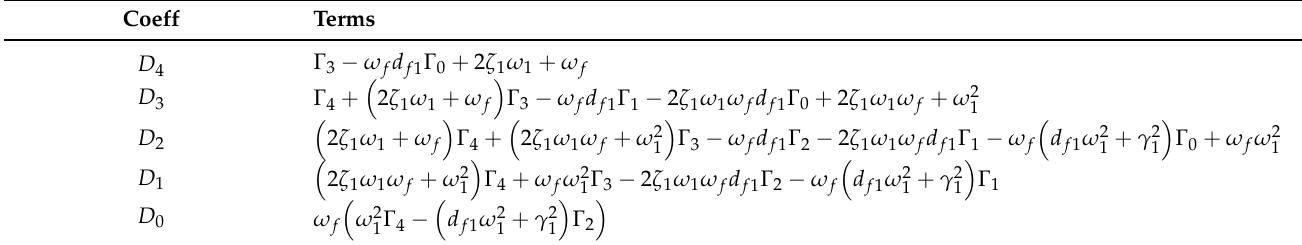
Table 6. Denominator coefficient